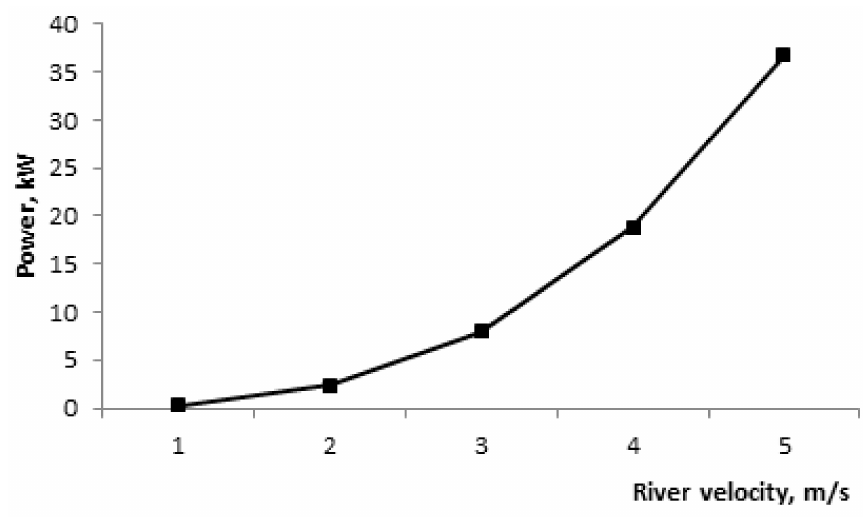
Figure 14. Calculated dependence of the power of the hydrobelt on the velocity of the water